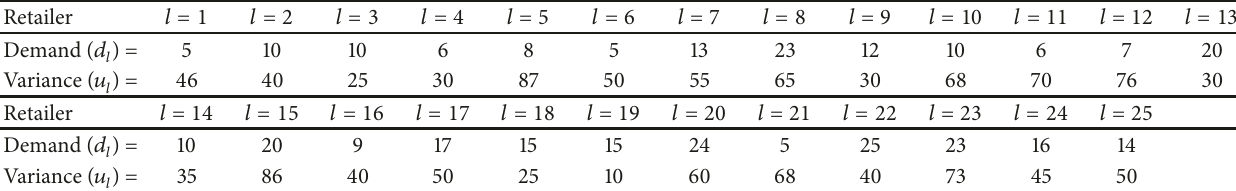
Table 3: Parameters of the base case, demand, and variance of retailers 𝑙 .